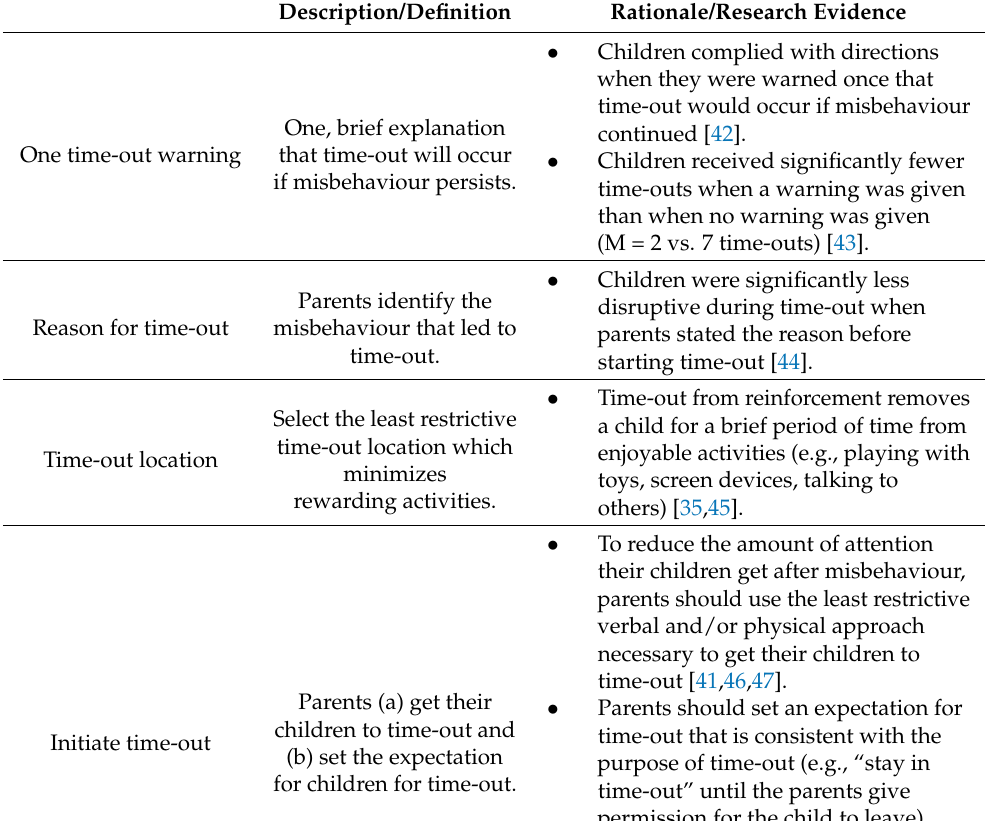
Table 1. Time-out components and their associated rationale.